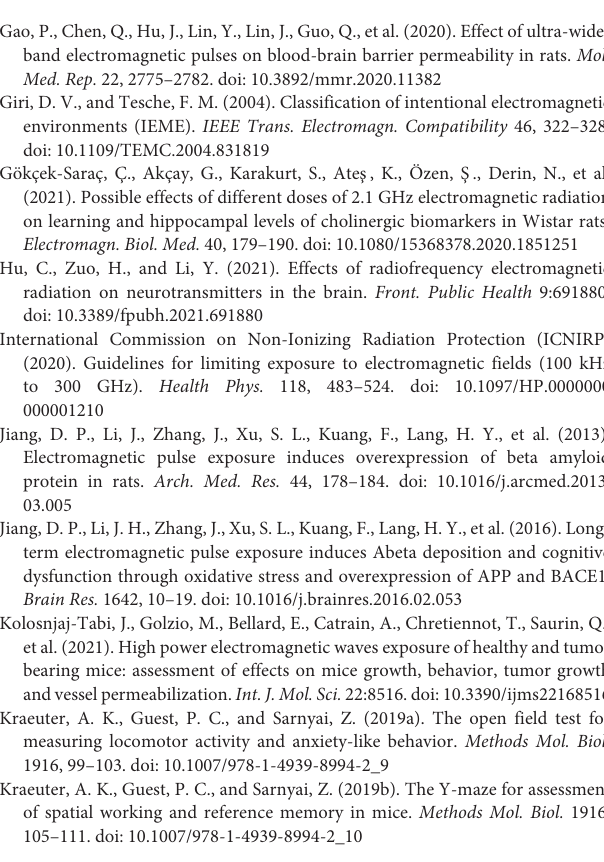
Supplementary Figure 1 | Fiber photometry on GFP-expressing mice, and GCaMP-expressing mice treated by sham exposure. (A) The (cid:52) F/F 0 (%) of GFP expressed in hippocampal CA1 area recorded by fiber photometry. 0 s for (cid:52) F/F0, marked by dotted lines, indicated that EMP exposure starting up, or mice entering central area in an open field (OF), or exploring a novelty during novel object exploration test (NOE). (B,C) Fiber photometry on GCaMP-expressing mice treated by sham exposure when seeking a novelty ( n = 3 mice). (B) The combined line diagram of calcium amplitude (cid:52) F/F 0 (%) in CA1 neurons before, and day 1, day 7 after sham exposure. 0 s for (cid:52) F/F0, marked by dotted lines, indicated that mice were exploring a novelty (NOE). (C) Plot of AUC in multiple trials from three biological replicates before and after sham exposure. The data are presented as mean ± SEM. One-way ANOVA followed by Bonferroni’s post-hoc tests were performed to evaluate the differences between multiple groups in (C)